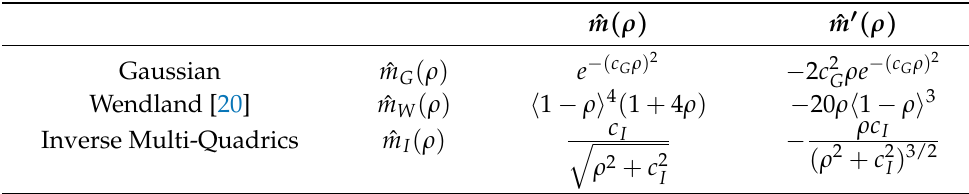
Table 1. Applied radial basis functions (here, expression (cid:104) a (cid:105) defines the Macaulay-brackets, (cid:104) a (cid:105) = a for a > 0 and (cid:104) a (cid:105) = 0 for a ≤